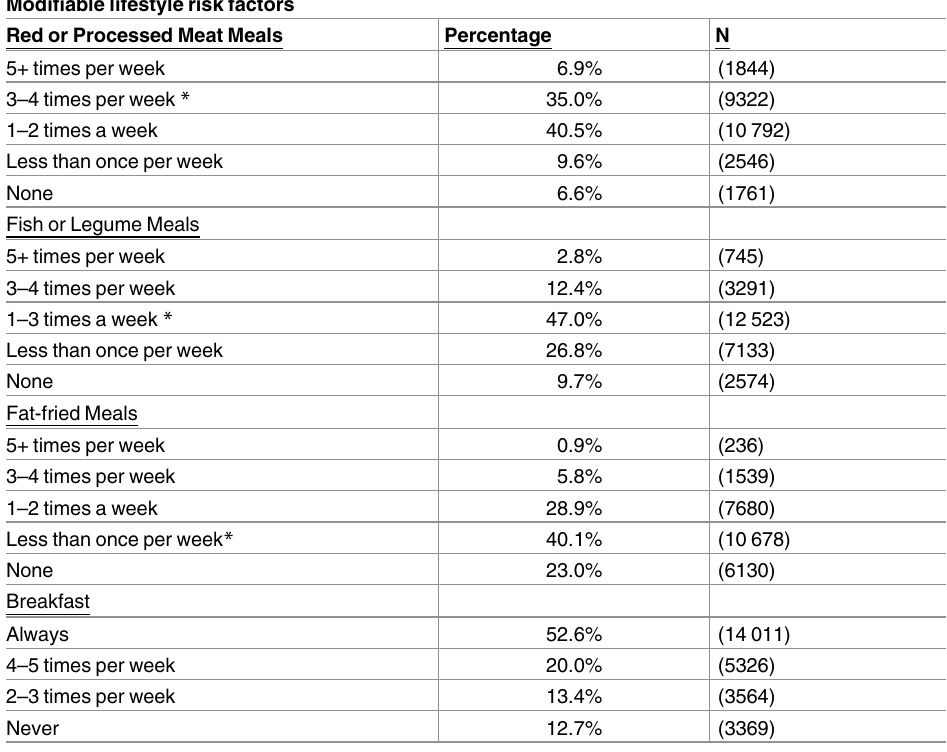
Table 4. Reported lifestyle behaviours by